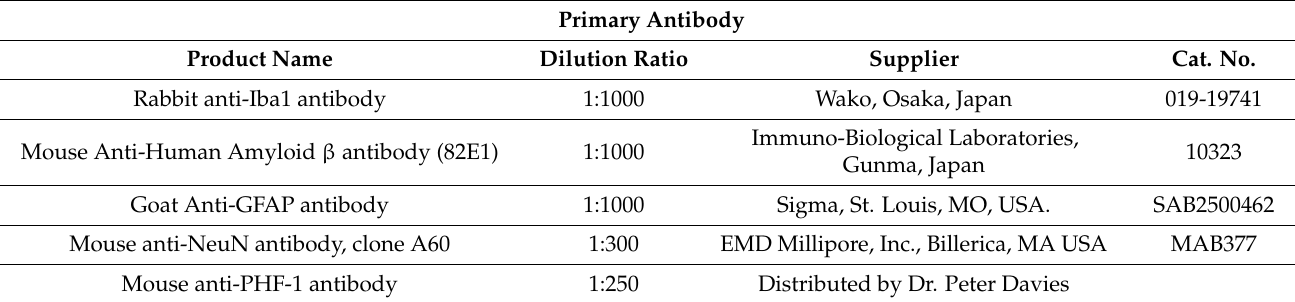
Table 1. Primary antibodies used for immunohistochemistry (IHC).